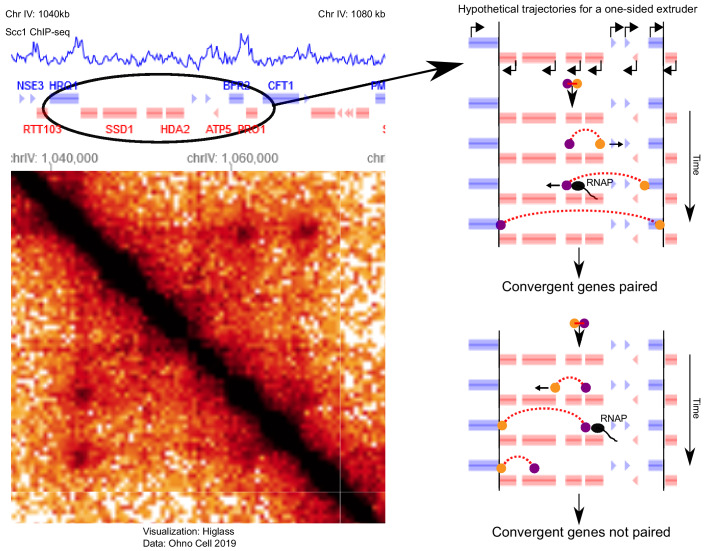
Illustration of how the moving barrier mechanism (Brandão et al., 2019) combined with one-sided LEFs may result in dots in Hi-C of S. cerevisiae.In the moving barrier model, RNA polymerase (RNAP) can push LEF subunits along chromatin. Left panel: ChIP-seq of the cohesin subunit Scc1 (Hu et al., 2015) and Hi-C (Ohno et al., 2019) in the S phase of S. cerevisiae. The selected region shows two dots between pairs of convergent genes that are enriched by Scc1. Right panels: two hypothetical trajectories for a one-sided LEF combined with the moving barrier mechanism for the region shown on the left. In the top scenario, a one-sided extruder is oriented such that the active subunit (yellow) extrudes to the right pair of convergent genes. The passive subunit (purple) is pushed by RNAP, resulting in 3D pairing of two pairs of convergent genes. Note that we assume that the passive subunit can be pushed across multiple genes; experiments have yet to show that this can actually happen. In the bottom trajectory, the one-sided LEF loads in a different orientation, such that the passive subunit is not pushed in the correct direction, and convergent genes are not paired. Since the orientation of loading of the LEF, as well as the orientation, activity, and density of genes determines whether a one-sided LEF pairs convergent genes, the moving barrier mechanism with one-sided LEFs is less efficient at pairing barriers than two-sided LEFs. However, the moving barrier mechanism may explain dot formation by one-sided LEFs between convergent gene pairs in S. cerevisiae (Dauban et al., 2020; Ohno et al., 2019), and we will discuss this mechanism elsewhere.